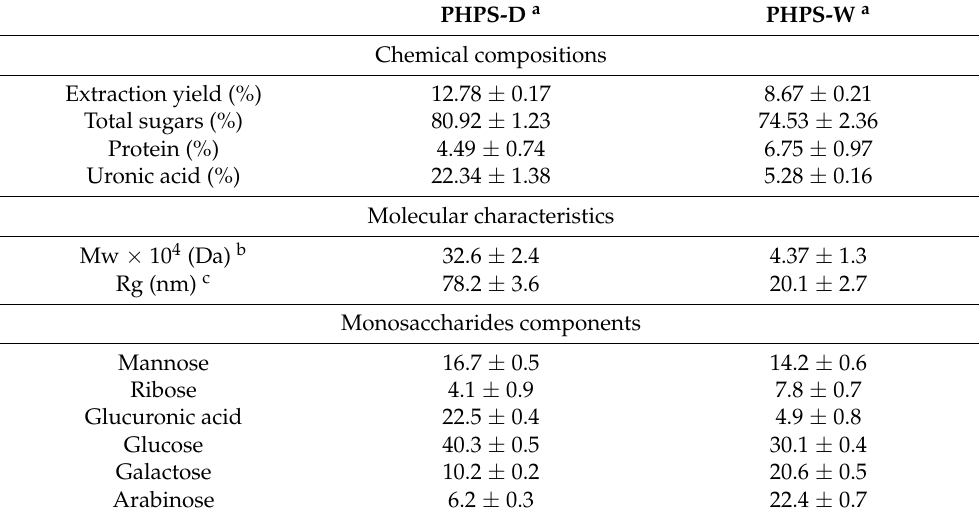
Table 3. Physicochemical properties of different polysaccharides prepared from Paecilomyces hepi- ali